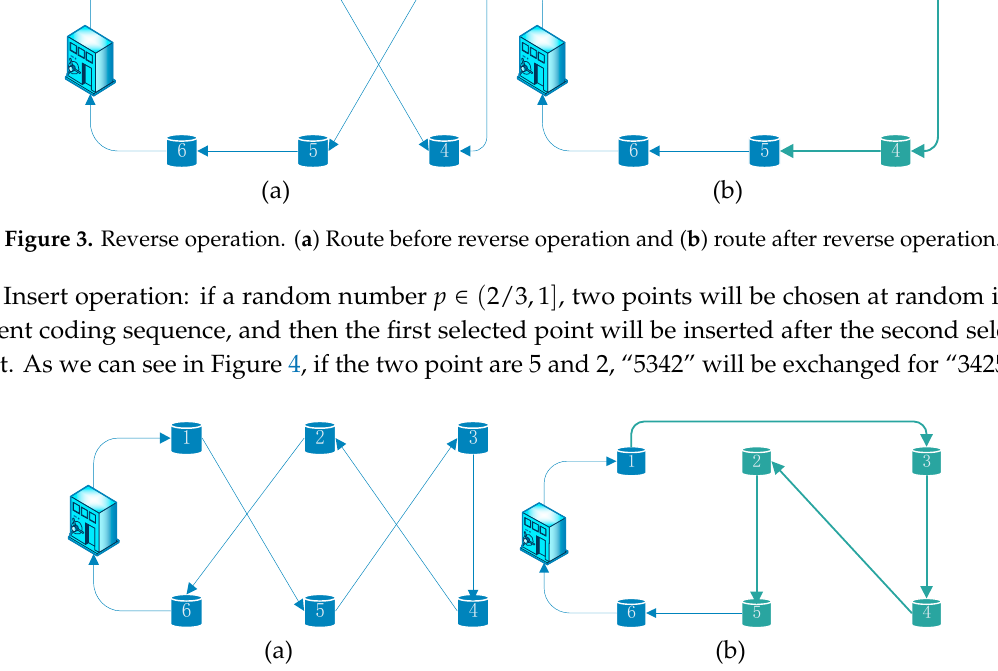
Figure 2. Swap operation. ( a ) Route before swap operation and ( b ) route after swap operation.